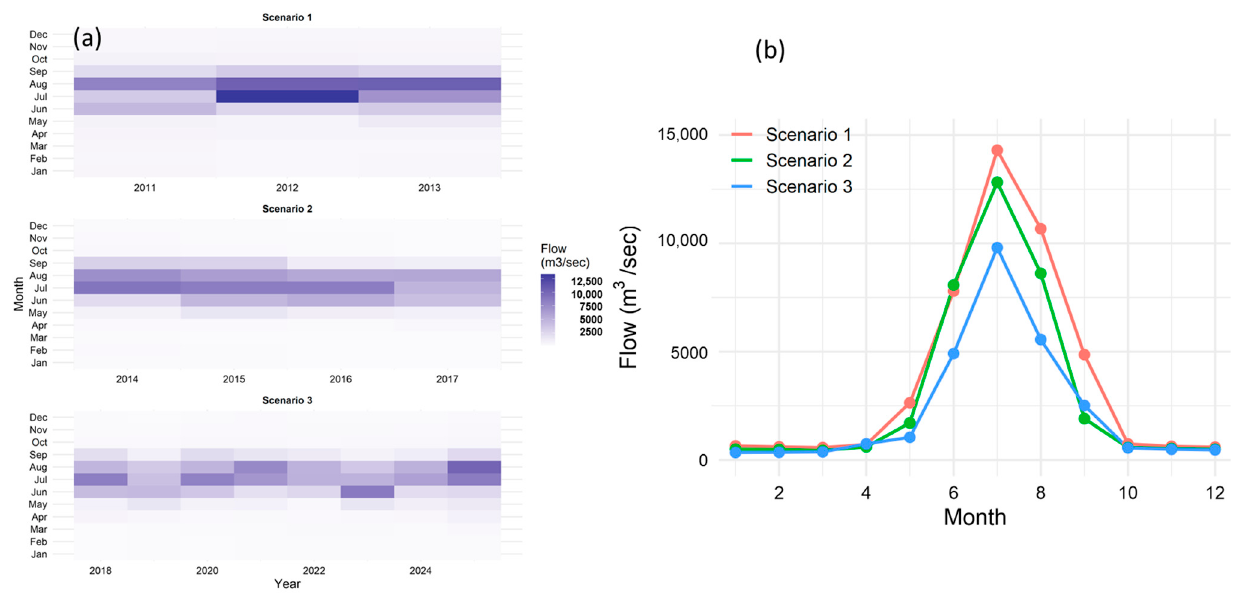
Figure 7. Monthly streamflow comparison between the first, second, and third scenarios. ( a ) Monthly time series and ( b ) monthly averages for all scenarios.